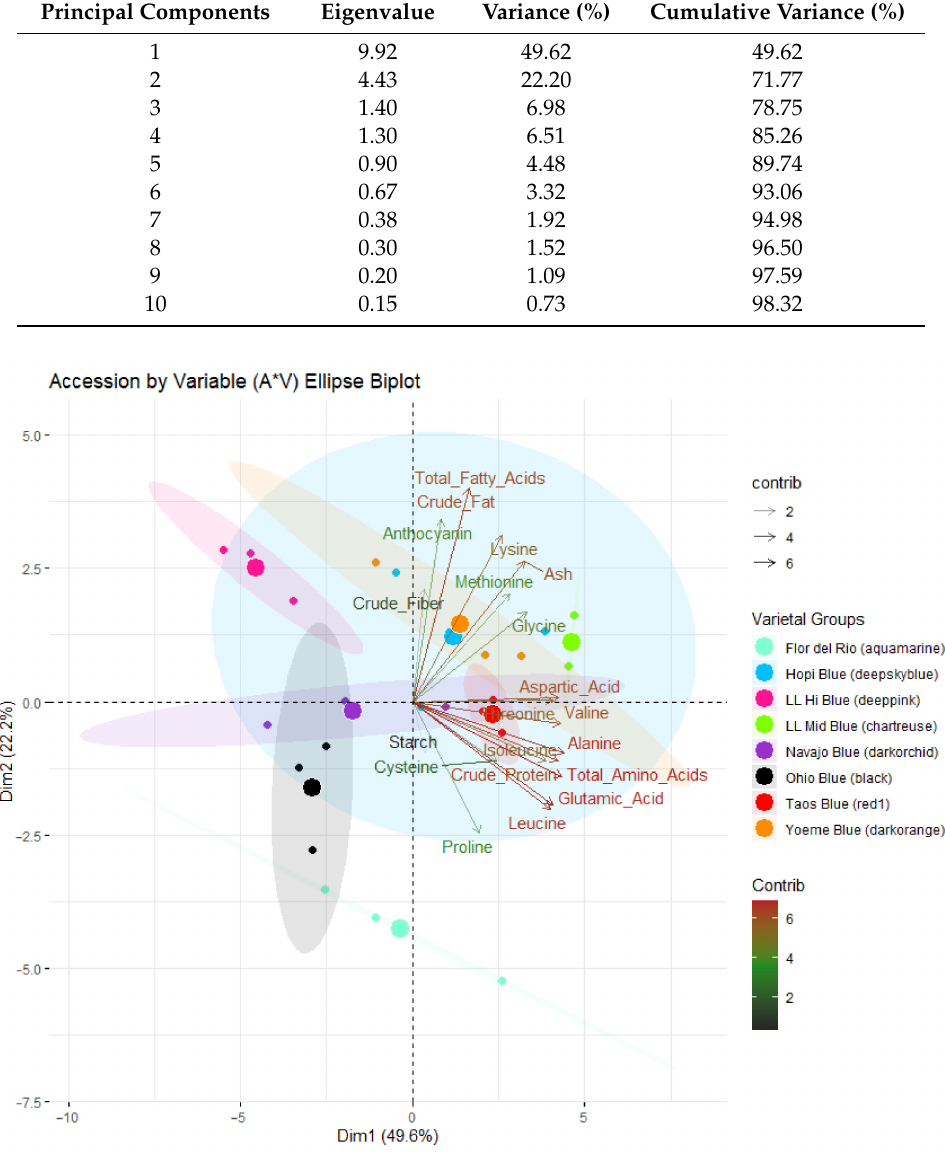
Figure 1. Accession by trait (A*T) biplot. Traits contributing to PC1 and PC2 are also assigned di ff erent gradient colors for a vector length 2, 4, and 6 with gray 15, Dodger blue, and firebrick, respectively. Small dots represent replicates of each accession, and the larger dot displays the center (mean) of the